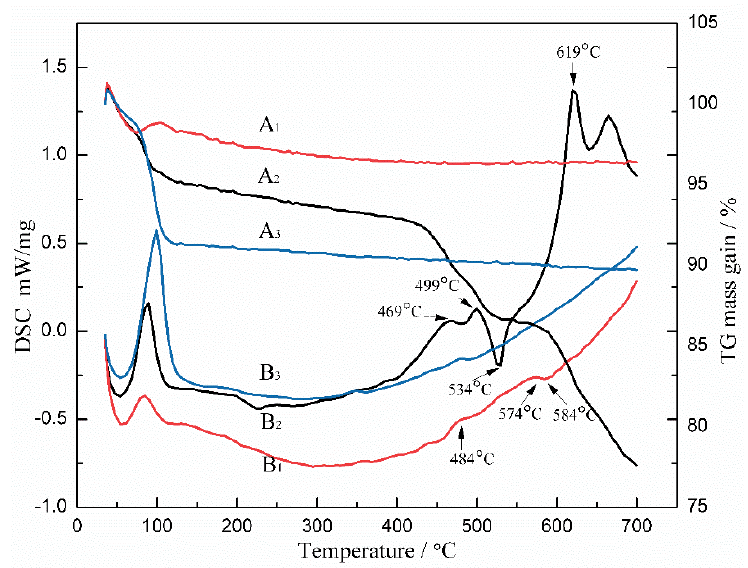
Figure 3. TG − DSC curves of glass, sodium carbonate, and the glass and sodium carbonate mixture. A1, B1: TG − DSC curve of glass, A2, B2: TG − DSC curve of glass and sodium carbonate mixture, A3, B3: TG − DSC curve of sodium carbonate.